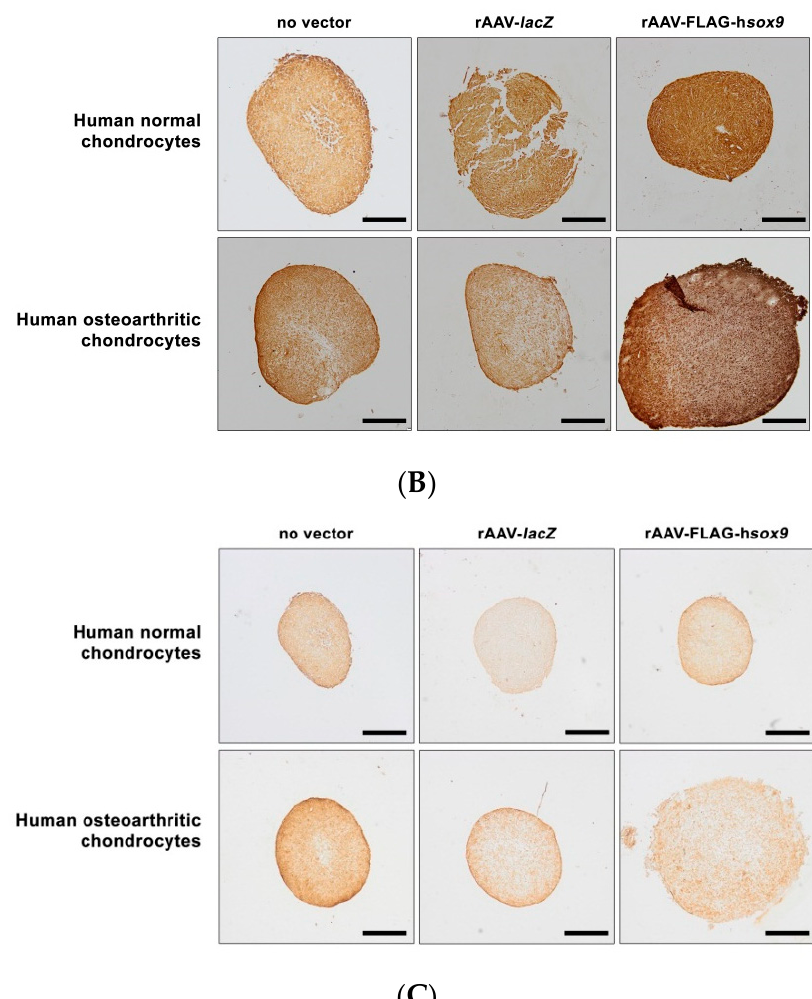
Figure 5. Extracellular matrix production in rAAV-transduced aggregate cultures of human normal and OA chondrocytes. Cell aggregates were transduced with rAAV-FLAG-h sox9 versus rAAV- lacZ (40 µ L each vector) or lack of vector treatment as described in Figures 1–4 and in the Materials and Methods. Extracellular matrix production was assessed after 21 days ( A ) by safranin O staining and ( B , C ) by immunohistochemical detection of type-II collagen ( B ) and type-X collagen ( C ) as described in the Materials and Methods (magnification x10; all representative data). Scale bars: 100 µ m.